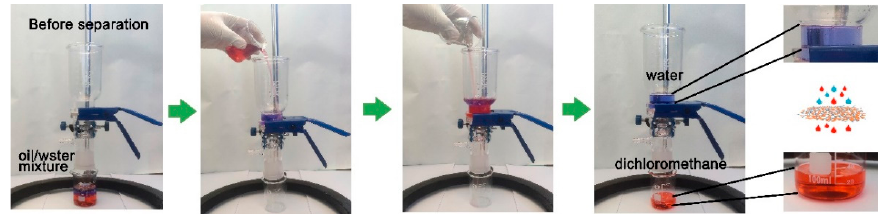
Figure 5. Dichloromethane–water mixture oil–water separation process diagram.